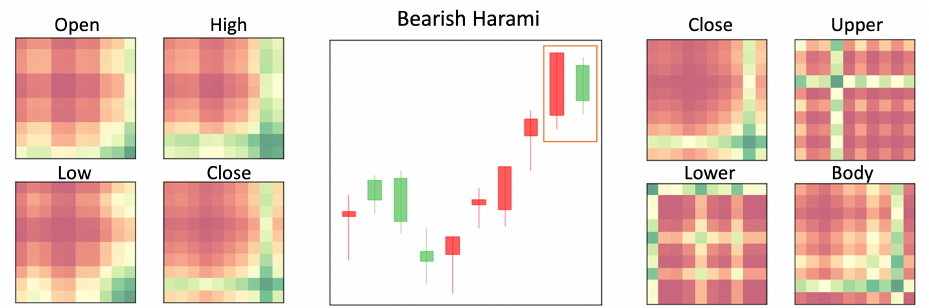
Figure 18. Example of Bearish Harami pattern and GASFs. The middlemost figure is the original candlesticks. The red and green candlesticks represent closing prices are higher than the opening prices are not. The left and right sides are the heatmaps of GASFs. The range of the heatmap is ( − 1,1 ) , where red equals − 1 and green equals